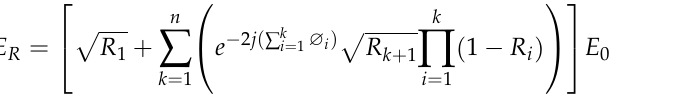
Figure 2. MFI characterization: ( a ) Reflection spectrum of the used MFI obtained using a broadband source at port 1 of an optical fiber circulator (OFC), the questioned MFI at port 2 of the OFC, and the OSA at port 3; ( b ) Spatial frequency analysis of the reflection interference spectrum.